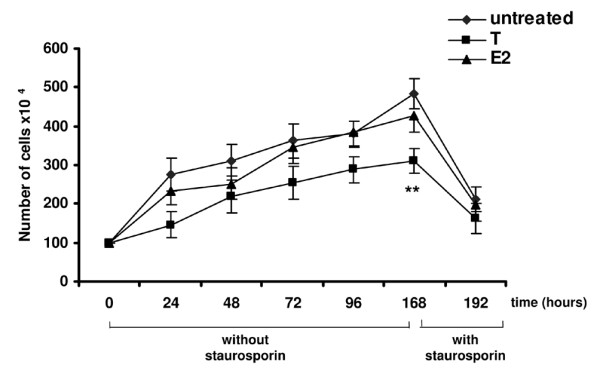
Growth rate of the cultured human THP-1 cell line without or with 17β-oestradiol (E2) and testosterone (T), and with staurosporine after 168 hours. The number of recovered live cells at different times was evaluated using the methyl tetrazolium salt reduction test. Results are expressed as the mean ± standard deviation of five different experiments.